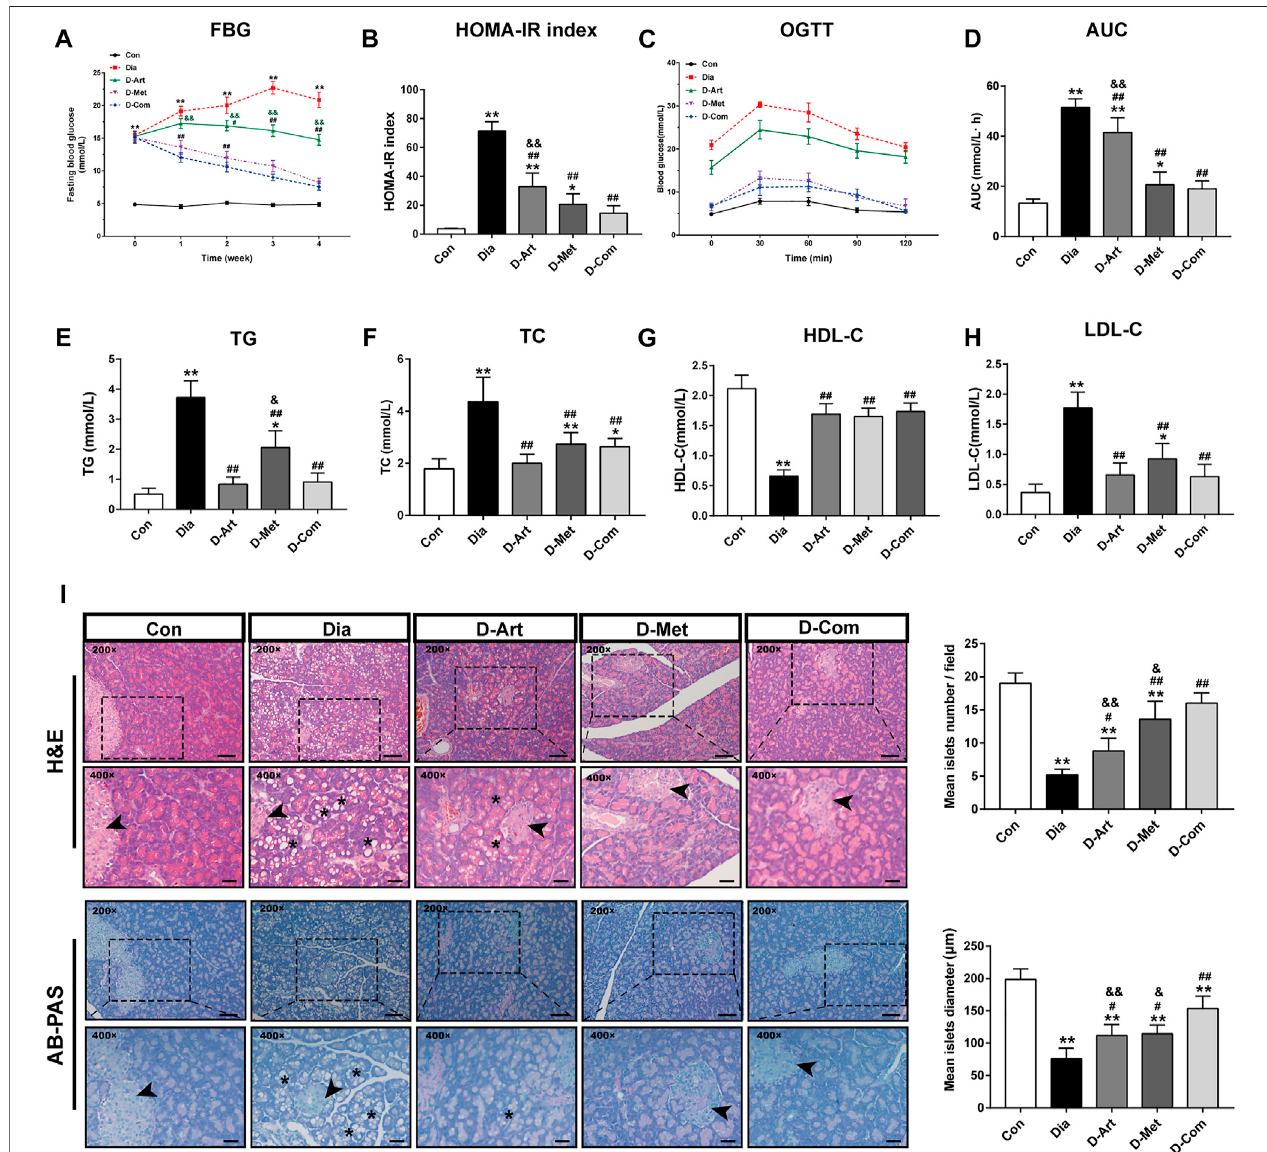
FIGURE3| ARTorMetaloneandART/MetcombinationalleviatetypicalT2DMcharacteristicsandpancreaticinjuryintheT2DMrats. (A) FBG, (B) HOMA-IRindex, (C) OGTT, (D) AUC of the OGTT, (E) TG, (F) TC, (G) HDL-C, and (H) LDL-C of rats in each group (8 rats per group). (I) H&E and AB-PAS staining of pancreas tissues in each group(5 ratsper group), scale bar (cid:1) 50 μ m (200 × );scale bar (cid:1) 20 μ m(400 × ).Pancreas islet sites arelabeled using blackarrows,while vacuolation islabeled using black *. Data are expressed as themean ± SD. * p < 0.05 and ** p < 0.01 versus Con group; # p < 0.05 and ## p < 0.01 versus Dia group; & p < 0.05 and && p < 0.01 versusD-Comgroup.OGTT,oralglucosetolerancetest;AUC,areaunderthecurve;TG,totalglyceride;TC,totalcholesterol;LDL-C,low-densitylipoproteincholesterol; HDL-C, high-density lipoprotein cholesterol; H&E, Hematoxylin & eosin; AB-PAS, Alcian Blue Periodic acid Schiff. Con, Normal control group; Dia, Untreated diabetic group; D-Art, ART-treated diabetic group; D-Met, Met-treated diabetic group; D-Com, ART/Met co-treated diabetic group.